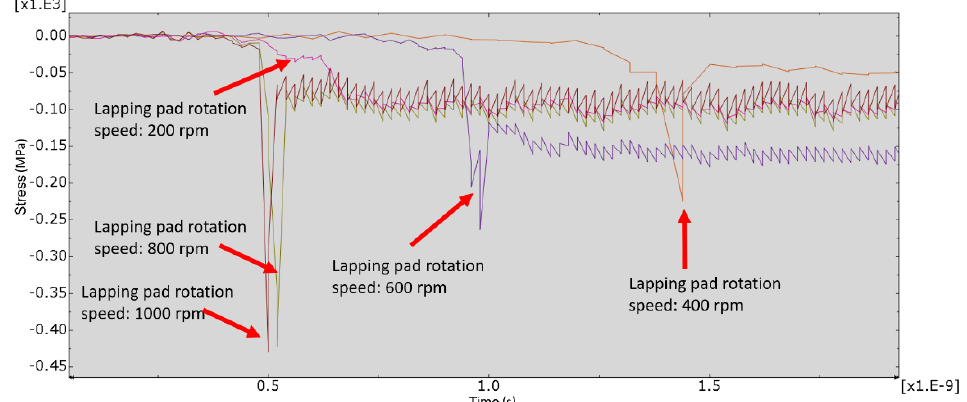
Figure 7. Stress – time curve of 1000 nm tool mark surface under different speeds.